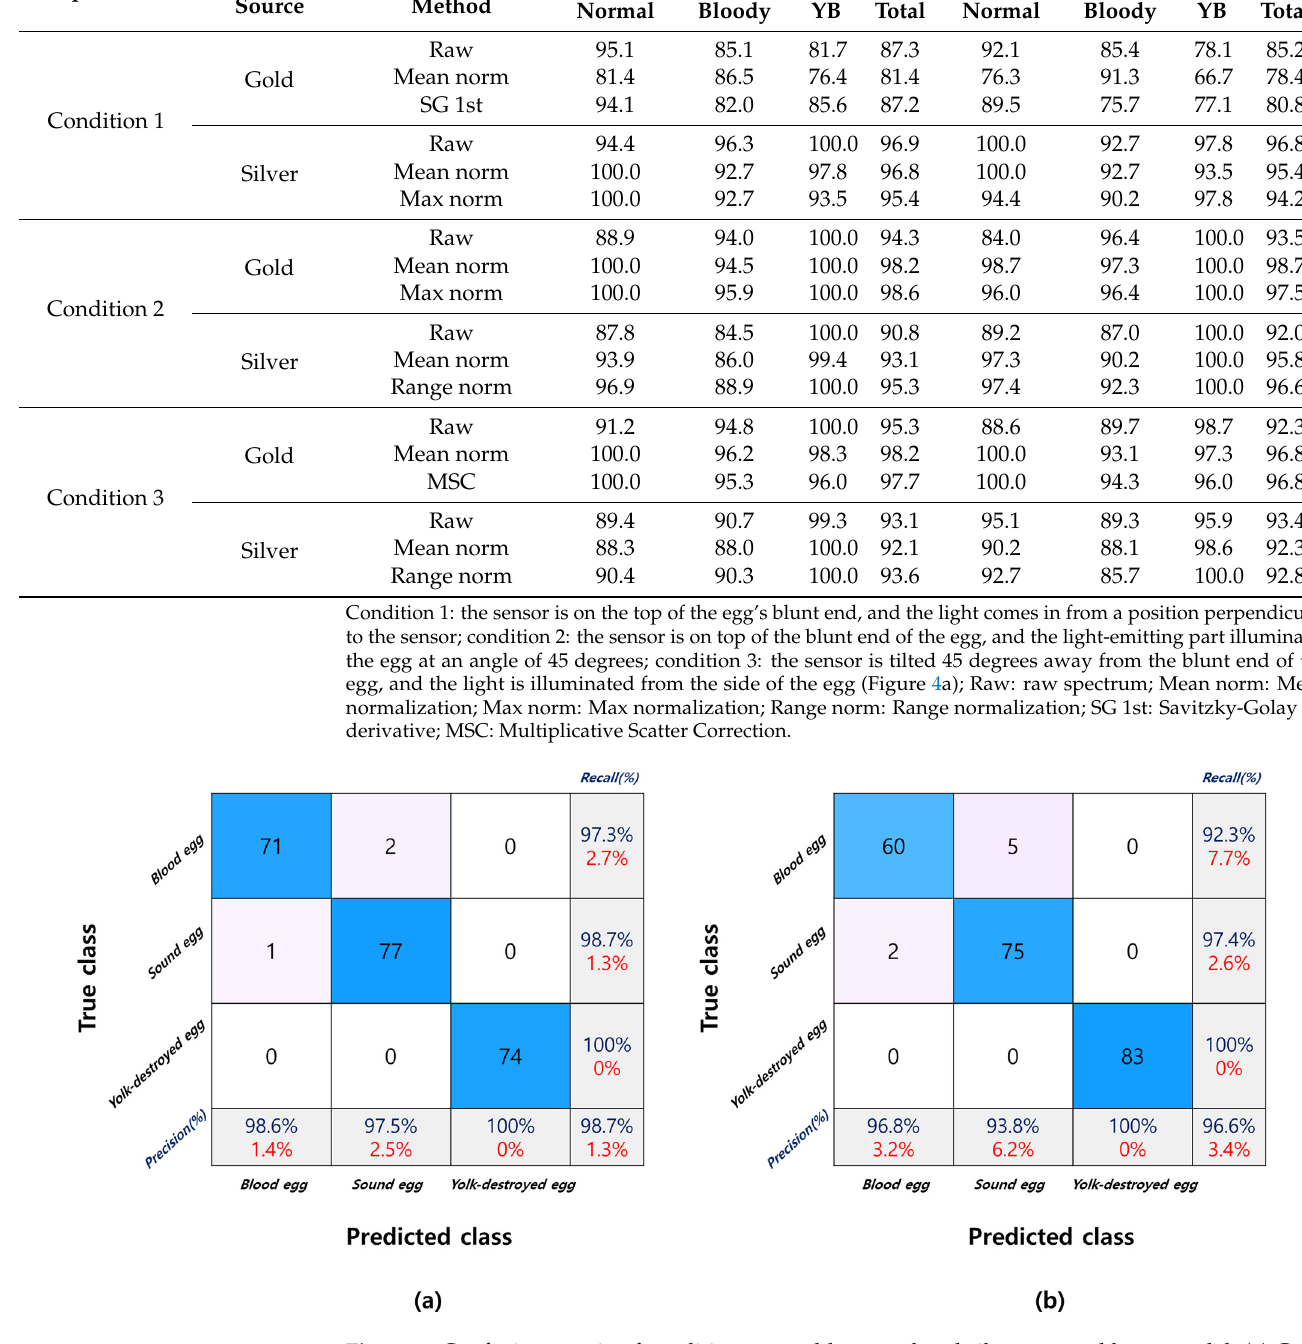
Figure 8. Confusion matrix of condition two gold − coated and silver − coated lamp model. ( a ) Gold- coated halogen tungsten lamp model; ( b ) Silver − coated halogen tungsten lamp model. The values in the parenthesis are errors.